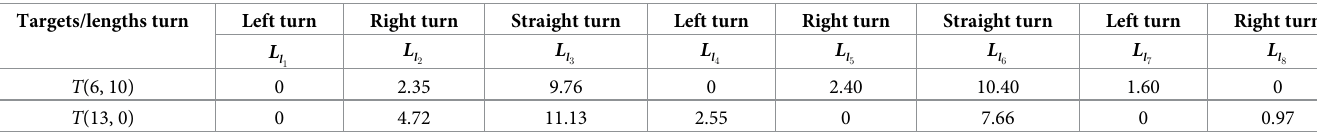
Table 1. Single target touring—Numerical performance of model (24). Targets/lengths turn Left turn Right turn Straight turn Left turn Right turn Straight turn Left turn Right